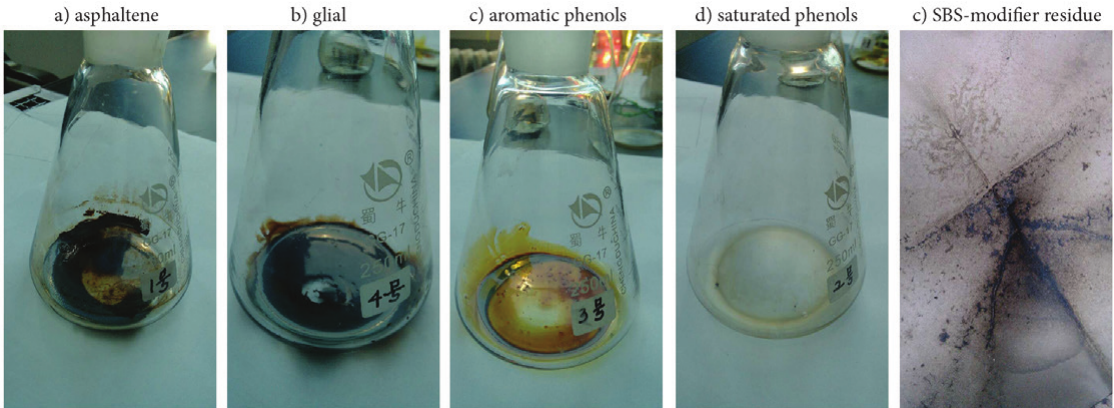
Figure 11. Bitumen four-component separation